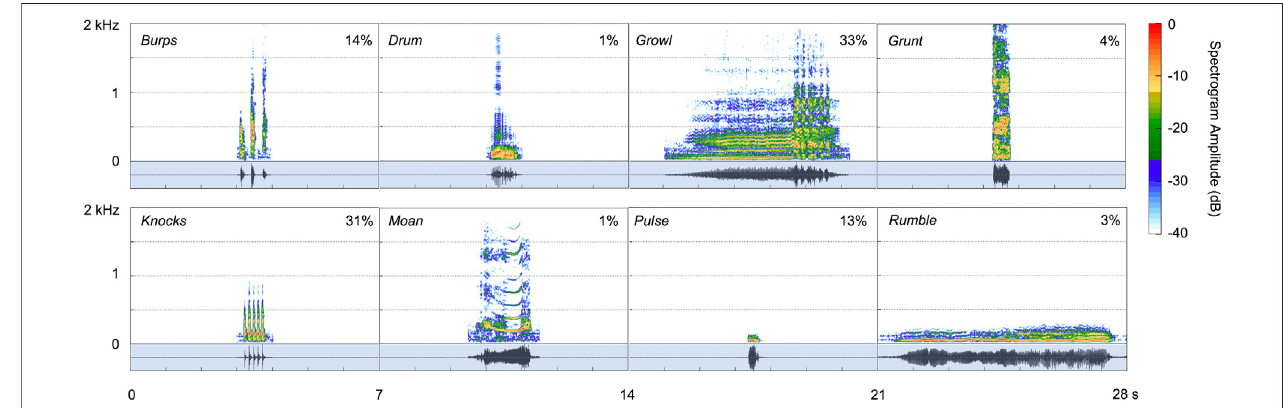
FIGURE5| Spectrograms forthe eight call types produced under waterby twomale spottedseals (Hanningwindow, sampling rate 48 kHz,window length 4,096 points, 90% overlap). Corresponding waveforms, shown in the shaded regions below the spectrograms, represent the relative amplitude of each vocalization. The proportion of each call type in the data set (out of 86,072 vocalizations identi fi ed) is shown as a percentage in each panel.